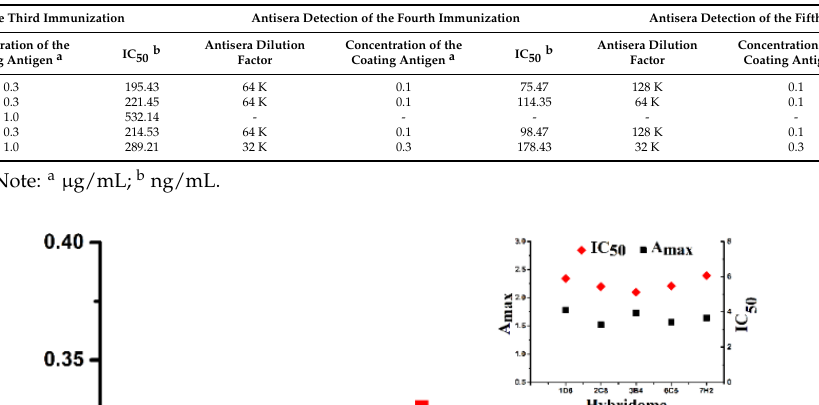
Table 1. Antisera detection results of endosulfan from the mice.